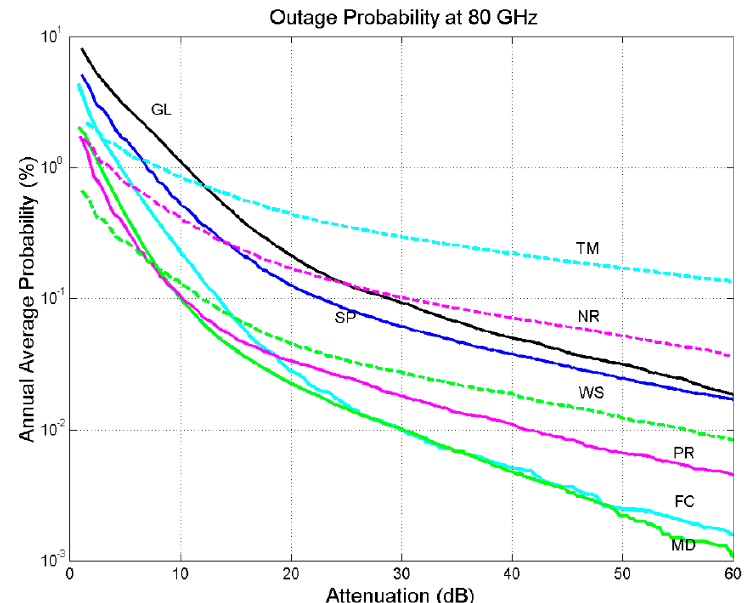
Figure 4. Annual average probability P ( A ) (%) of exceeding the rain attenuation A (dB) indicated in abscissa, at the indicated sites: Spino d’Adda (SP, blue continuous line); Gera Lario (GL, black continuous line); Fucino (FC, cyan continuous line); Madrid (MD, green continuous line); Prague (PR, magenta continuous line); Tampa (TM, cyan dashed line); Norman (NR, magenta dashed line); White Sands (WS, green dashed line), at 80 GHz in zenith paths. When the power margin in the zenith radio-links of the GeoSurf satellite constellations is equal to (cid:1827) (dB), (cid:1842)((cid:1827)) represents the outage probability.